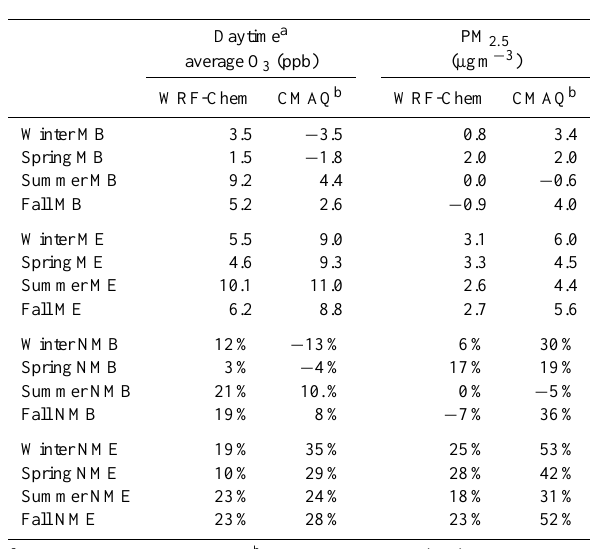
Table 2. WRF-Chem and CMAQ seasonal O 3 and PM 2 . 5 prediction performance.